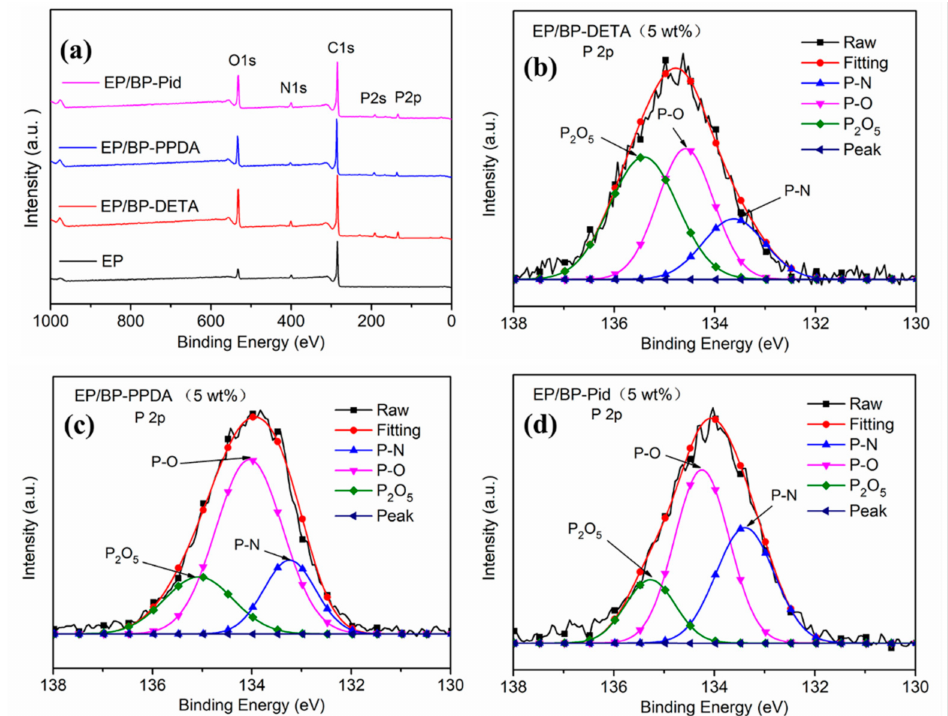
Figure 10. ( a ) XPS survey spectra of the residual char for pure EP and EP/BP-NH 2 nanocomposites after cone tests; high-resolution P2p XPS spectra of ( b ) EP/BP-DETA (5 wt%), ( c ) EP/BP-PPDA (5 wt%), and ( d ) EP/BP-Pid (5